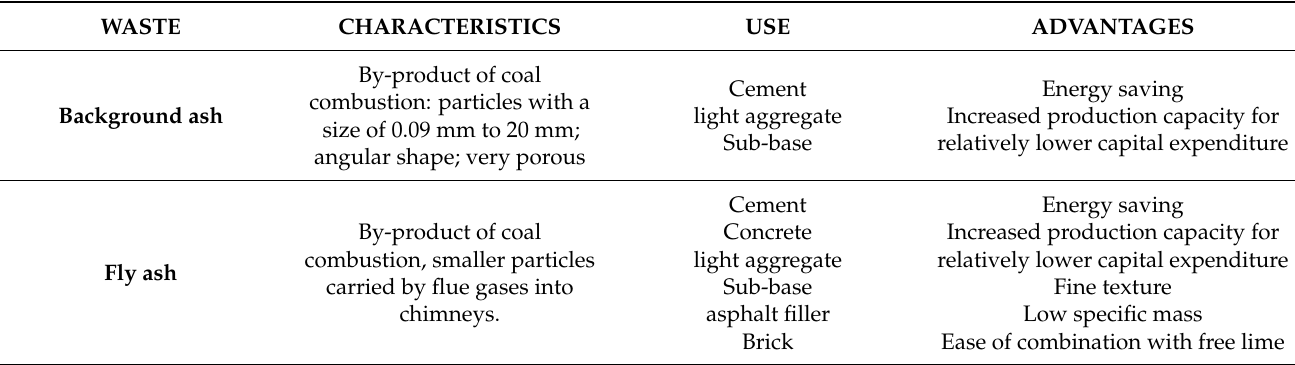
Table 1. Overall assessment of waste and by-products